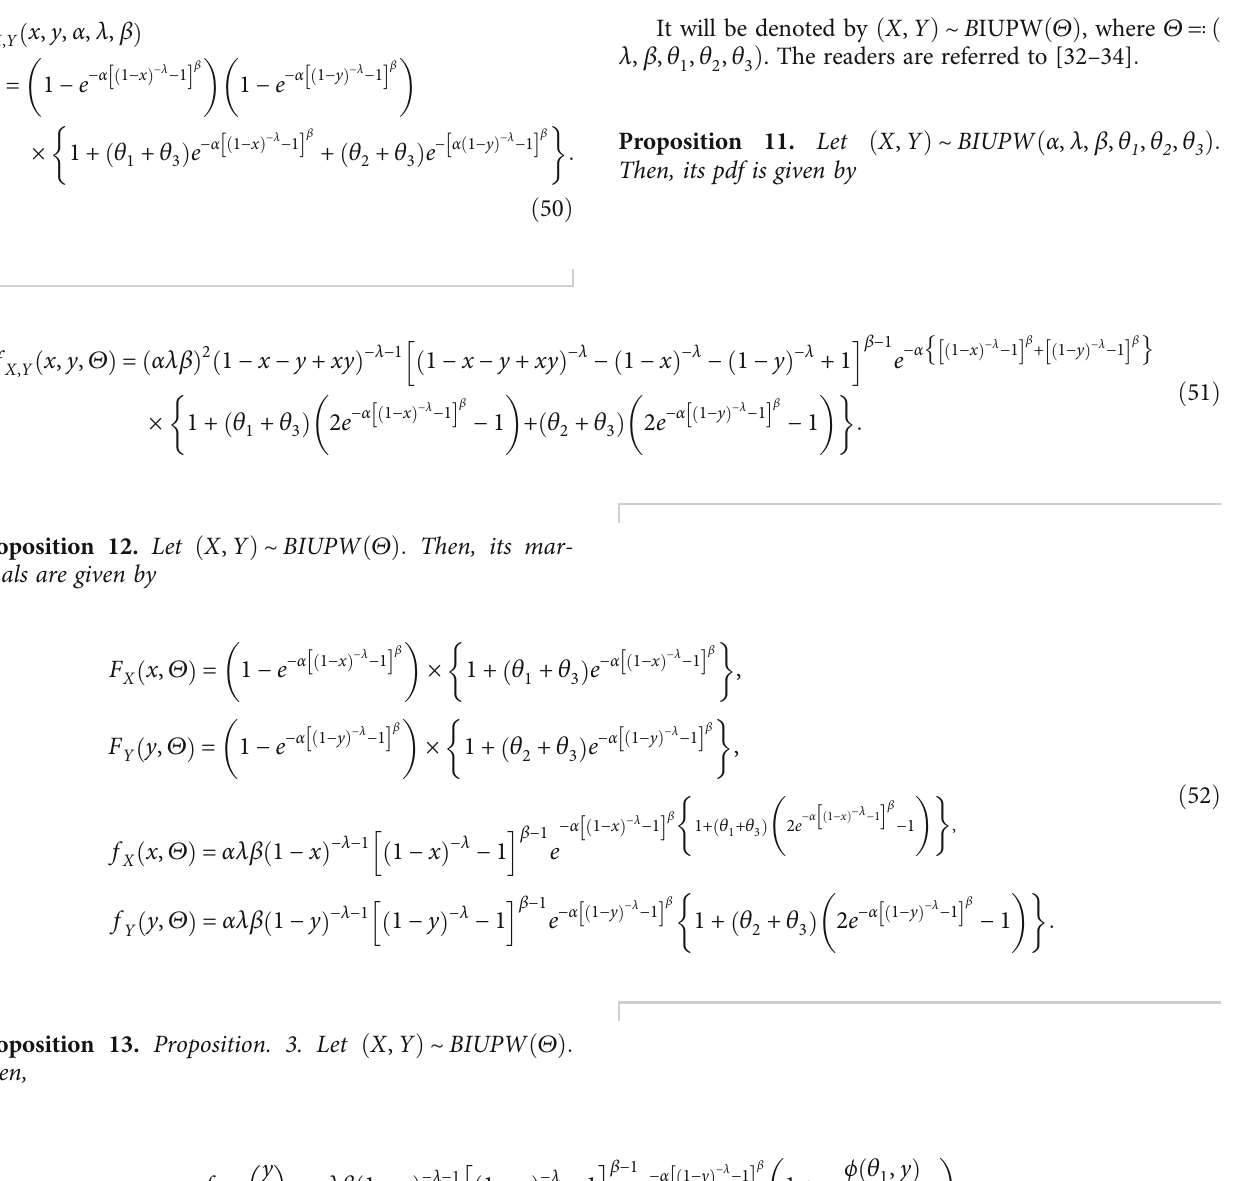
Figure 14: Graphical illustration of estimated pdf, cdf, failure rate, and P-P for data